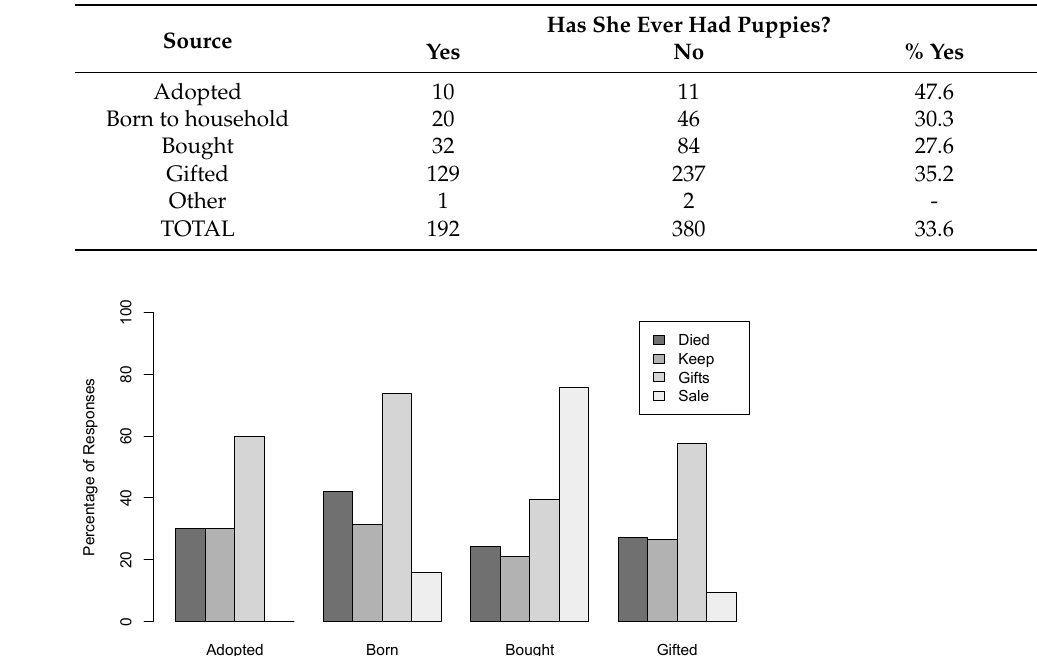
Table 6. If a female dog had litter in her life based on the source of acquisition in Quezon City.